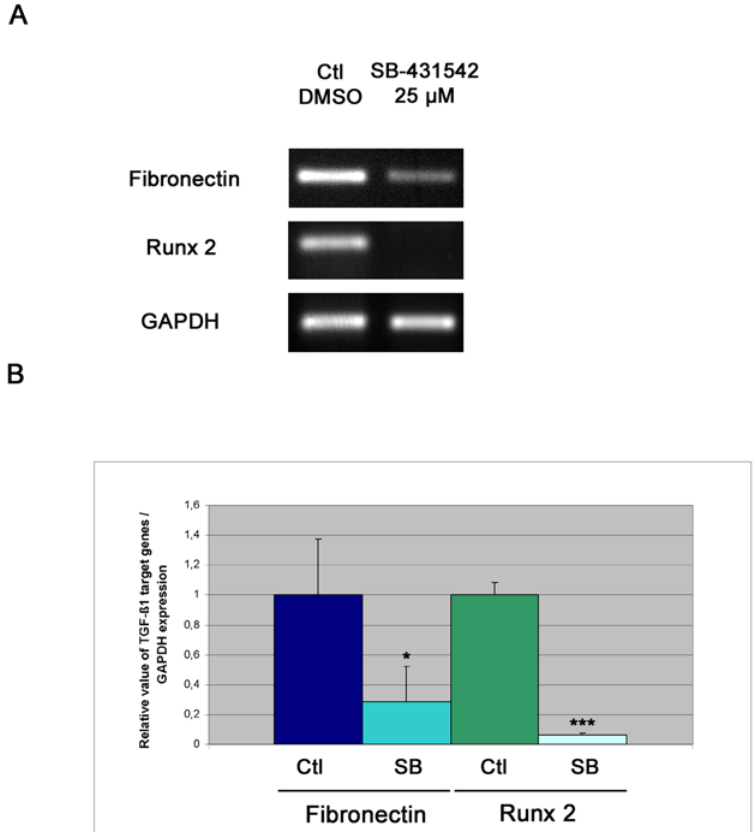
Figure 7. Inhibition of TGF- b 1 target genes expression in regenerating limbs treated with SB-431542. A) RT-PCR showing expression of fibronectin and Runx 2 in axolotl regenerating forelimbs. RT-PCR reactions were performed on at least 4 separate RNA samples extracted from pools of 6 blastemas of animals treated with DMSO or SB-431542. Fibronectin and Runx 2 were strongly expressed in control limbs and significantly down- regulated in limbs treated with SB-431542. GAPDH was used as a control. B) Graph representing the relative value of fibronectin/GAPDH and Runx 2/ GAPDH expression in control and SB-431542 treated limbs. Fibronectin and Runx 2 relative expression in control limbs were fixed to 1 6 0.37 and 1 6 0.09 respectively. The relative expression values in SB-431542 treated limbs were 0.29 6 0.23 with a p , 0.05 (*) for fibronectin and 0.07 6 0.01 with a p , 0.001 (***) for Runx 2.